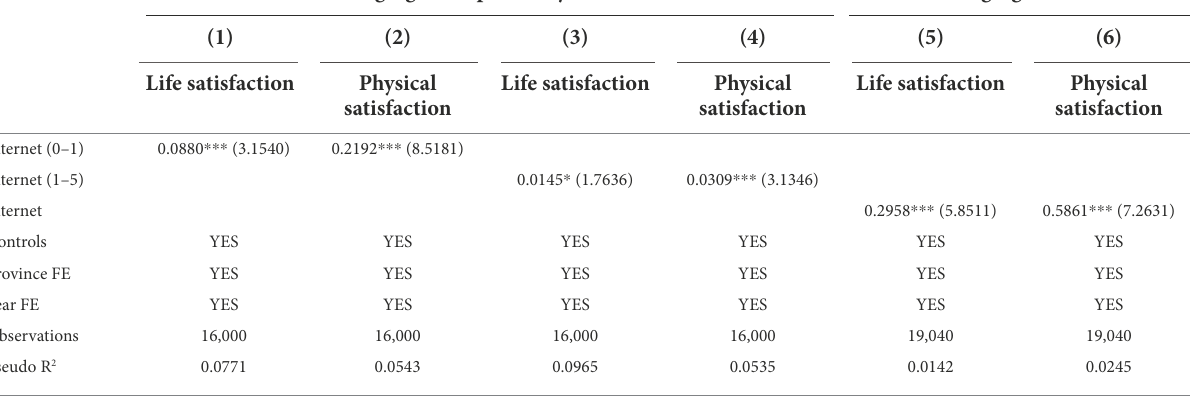
TABLE 3 Robustness